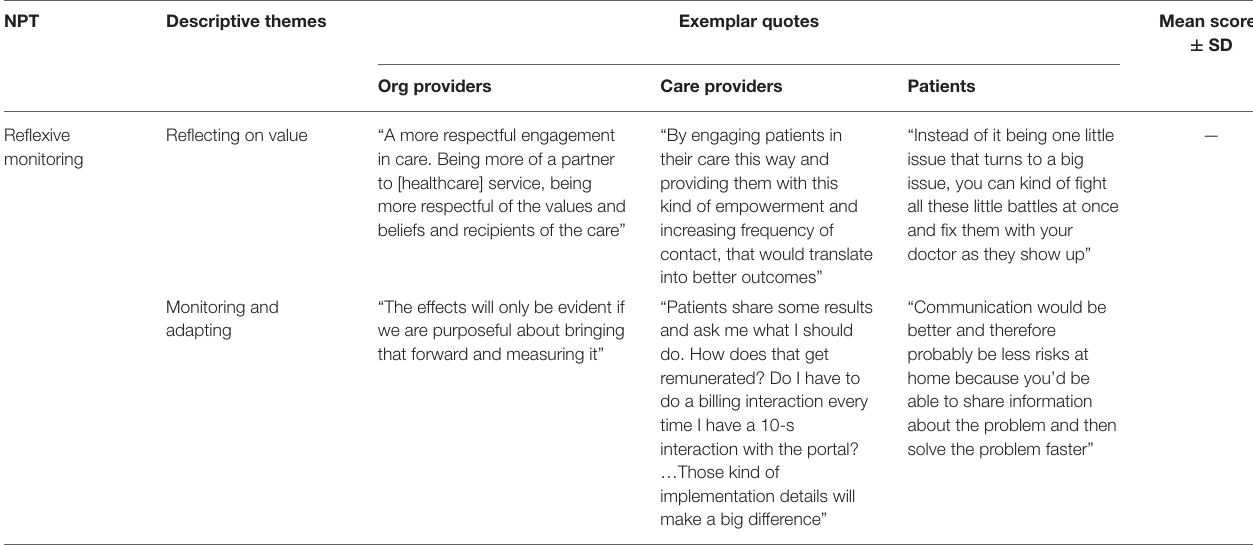
TABLE 8 | Combined qualitative and quantitative results for reflexive monitoring by study group.